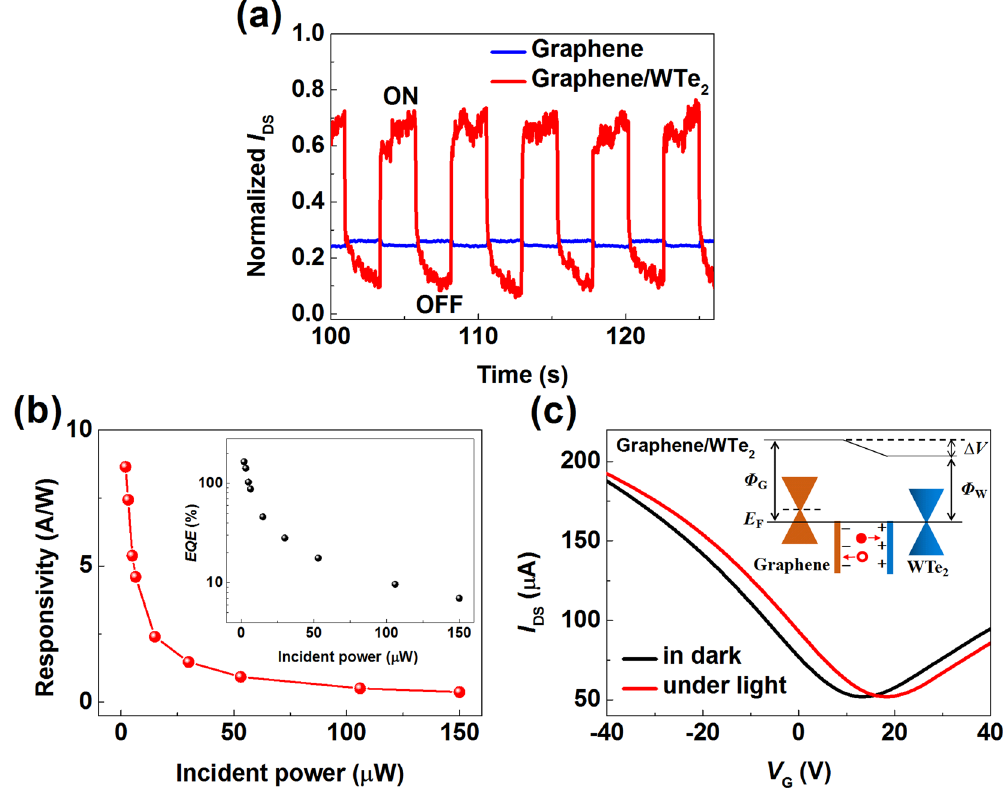
Figure 2. Photoresponse of the graphene/WTe 2 hybrid device. (a) Time-resolved photoresponse of the graphene/WTe 2 heterostructure device and pure graphene device under 650 nm laser switching on/off. (b) Responsivity of the graphene/WTe 2 phototransistor as function of the incident light power under 650 nm illumination. (c) EQE of the hybrid device as function of the incident light power under 650 nm illumination. (d) Transfer curves of the graphene/WTe 2 device in dark and under 650 nm laser illumination at V DS = 0.5 V. Inset: Schematic diagram of potential step formation and the photo-induced carriers transporting process under light at the graphene-WTe 2 interface. Φ G is the work function of graphene, Φ W represents the work function of WTe 2 , ∆ V is the built-in potential difference. Solid sphere represents photo-induced electron, and hollow sphere is photo-induced